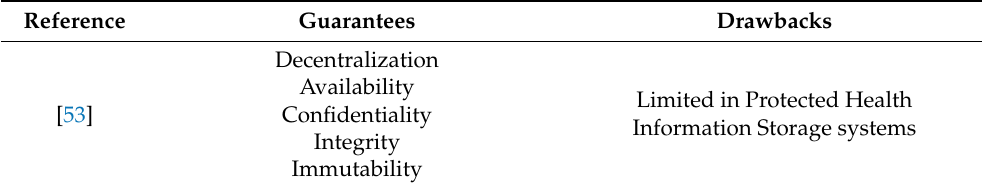
Table 3. Blockchain-based Authorization Mechanisms in IoT